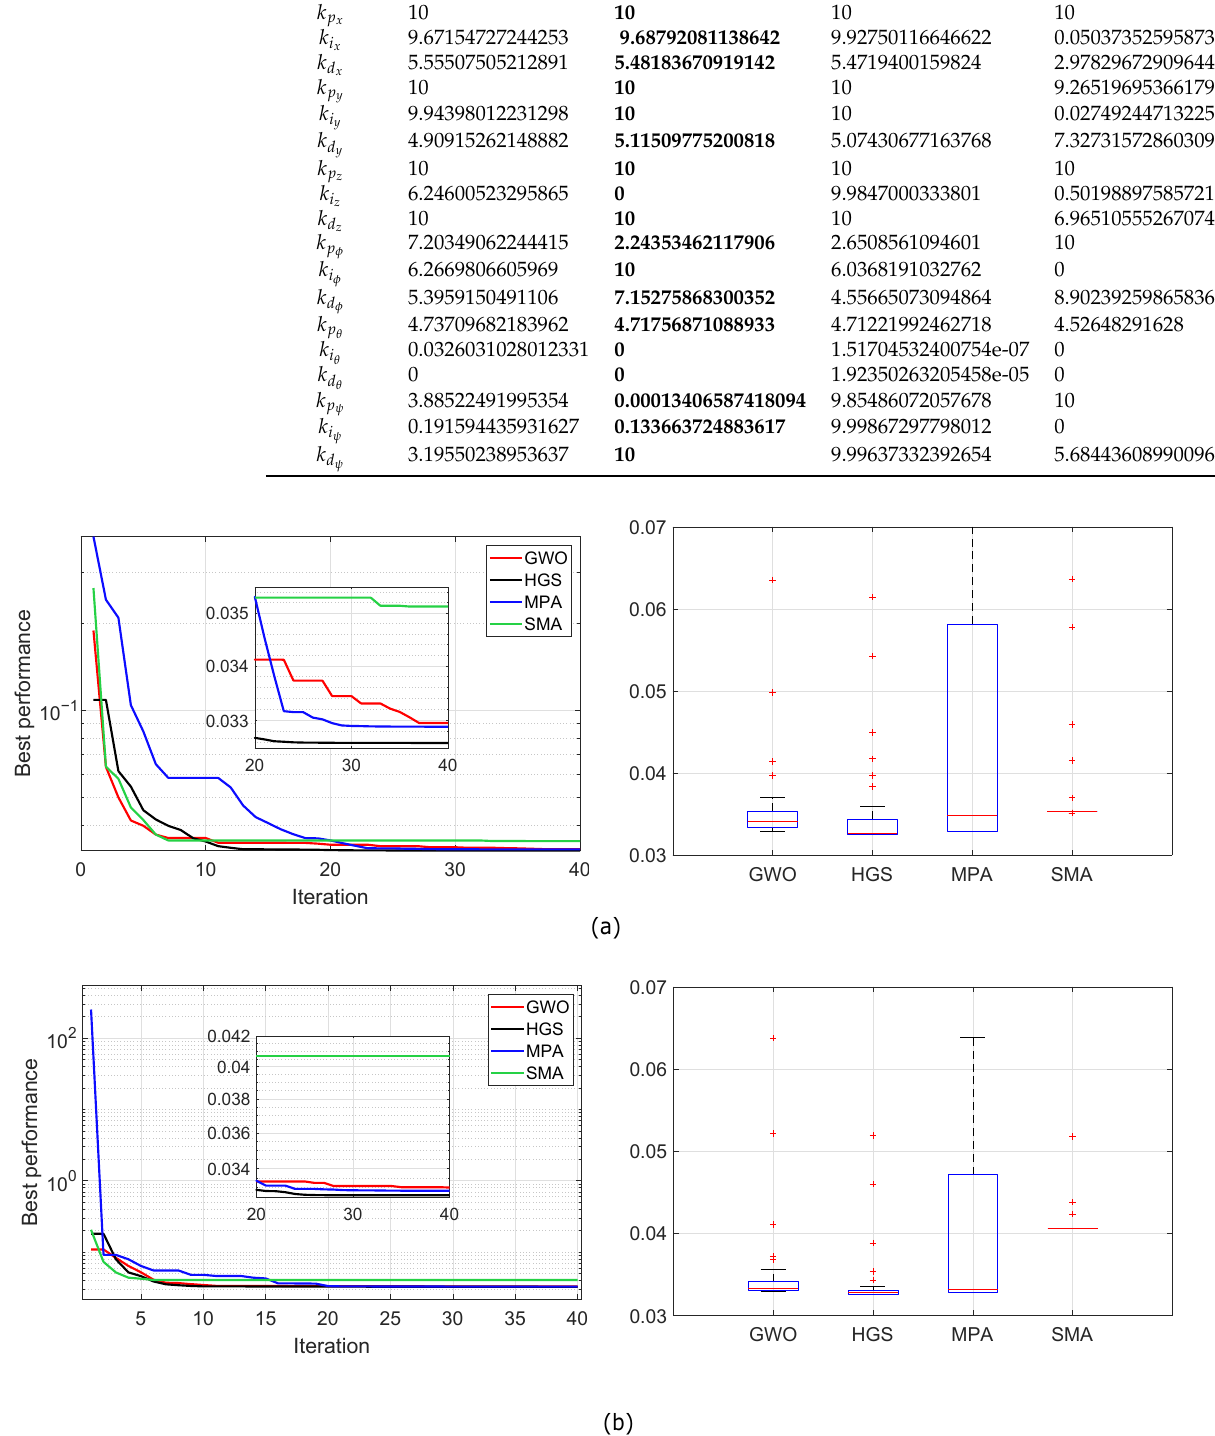
Figure 15. Convergence curves of RMSE and boxplot distribution of the different algorithms, 40 itera- tions and different individuals. ( a ) 80 individuals, 40 iterations; ( b ) 100 individuals, 40